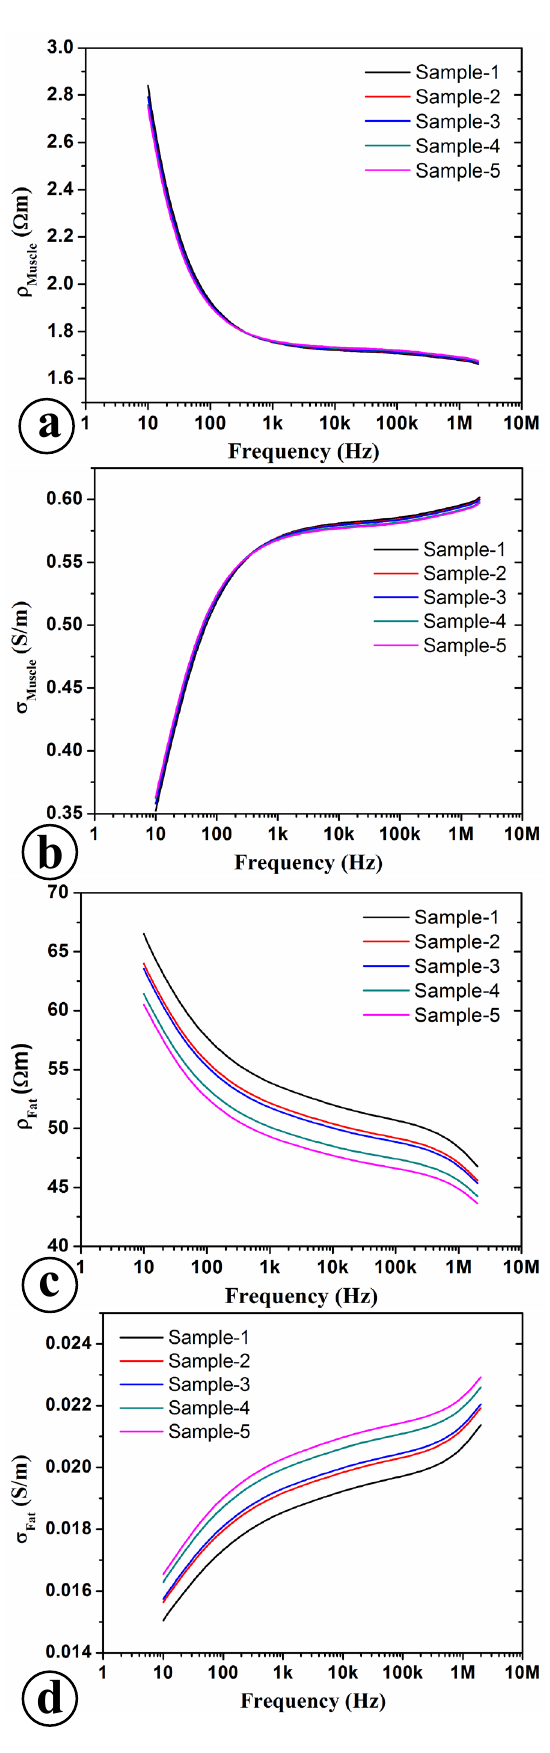
Figure-7: Variation of impedance parameters of chicken tissue over frequency: (a) ρ Muscle Paste , (b) σ Muscle Paste , (c) ρ Fat , (d) σ Fat .